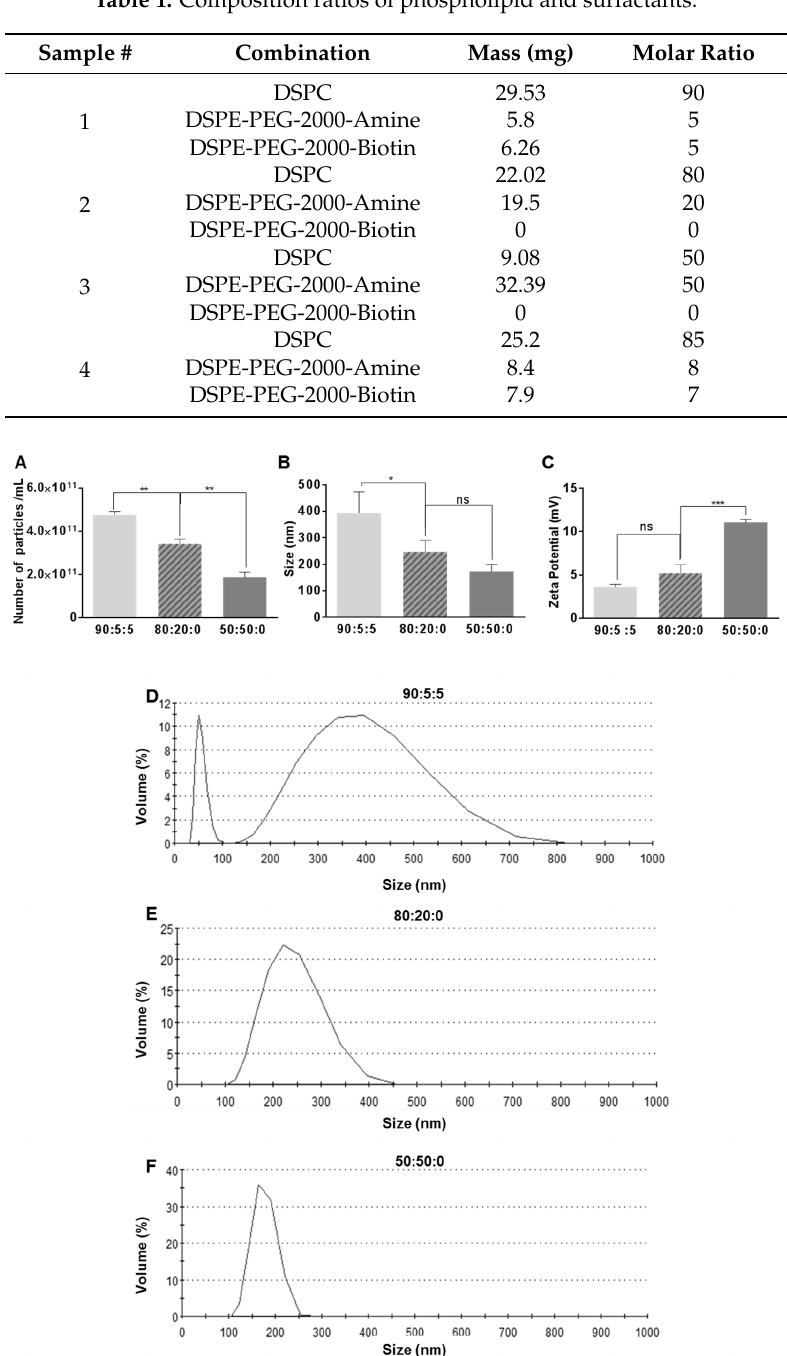
Table 1. Composition ratios of phospholipid and surfactants.